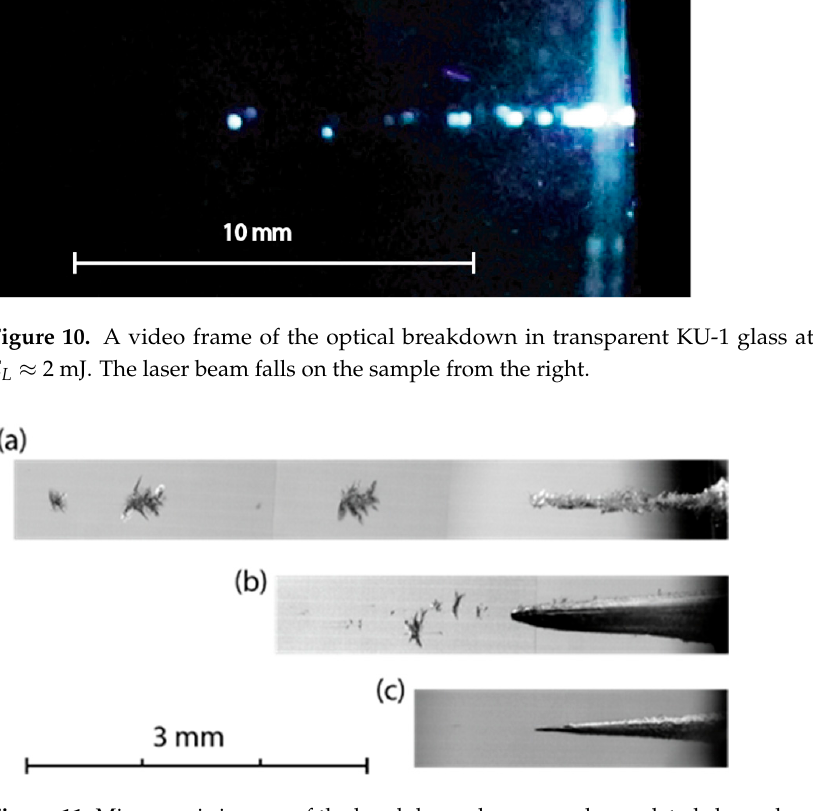
1 glass by a rep-rate irradiation at 10 Hz with pulse energies ( a ) E L ≈ 2.1; ( b ) E L ≈ 5.1; ( c ) E L ≈ 22 mJ.